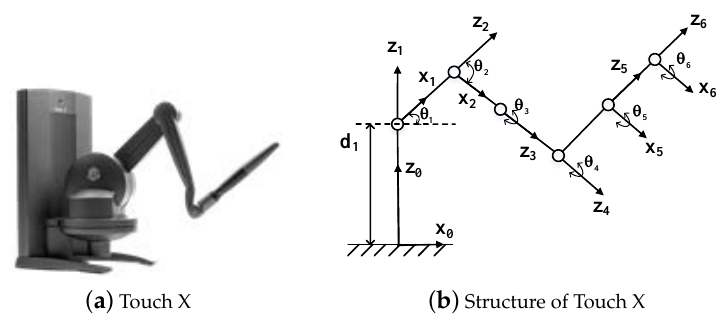
Figure 1. Physical structure model of Touch X. ( a ) Touch X. ( b ) Structure of Touch X.